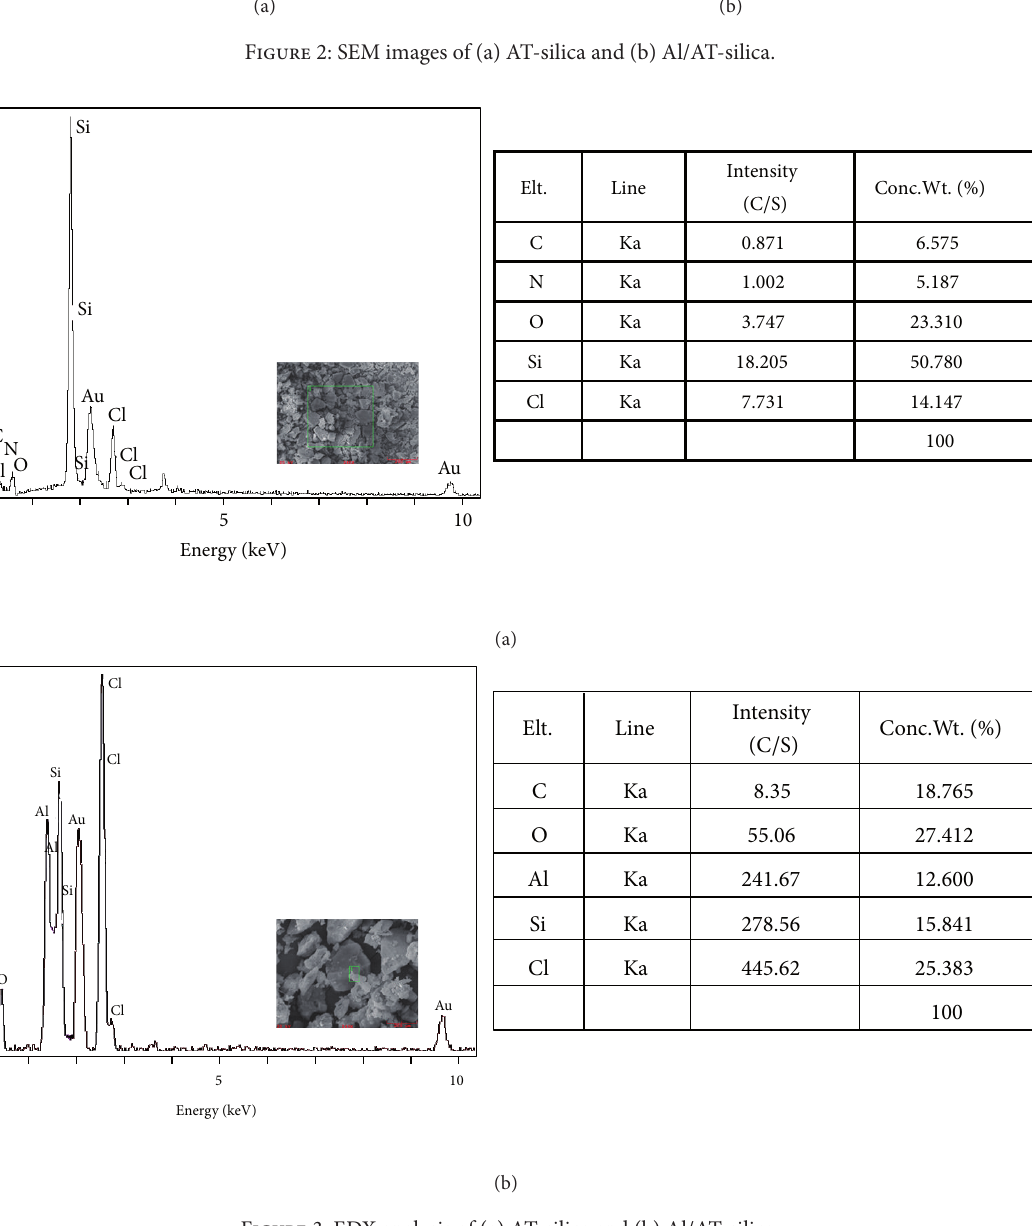
F 3: EDX analysis of (a) AT-silica and (b)